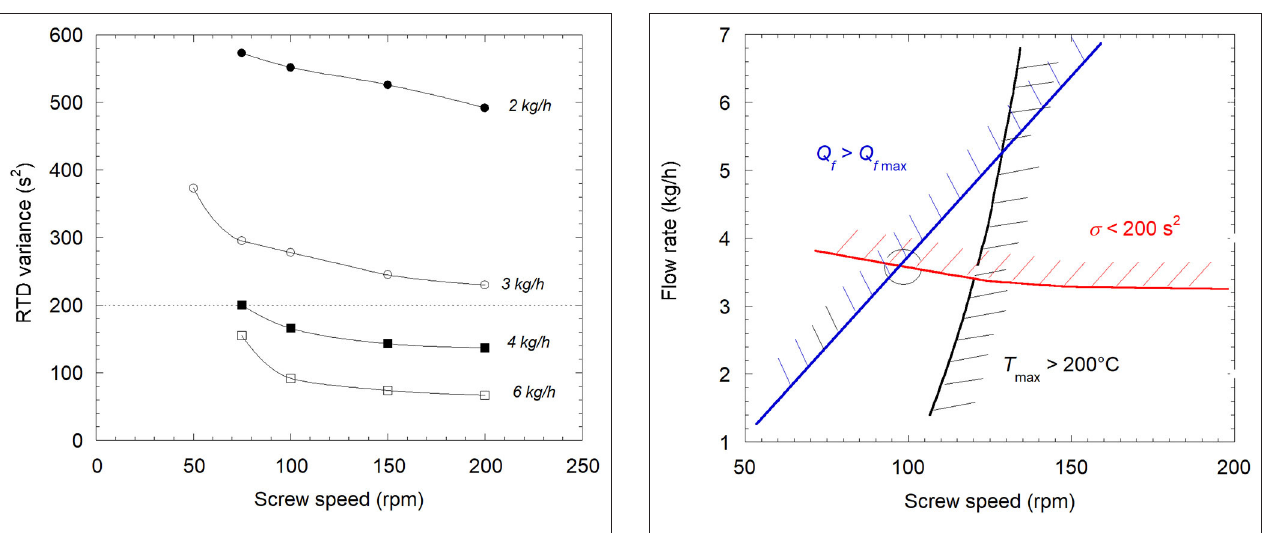
FIGURE 4 | Changes in RTD variance with screw speed for different feed rates.